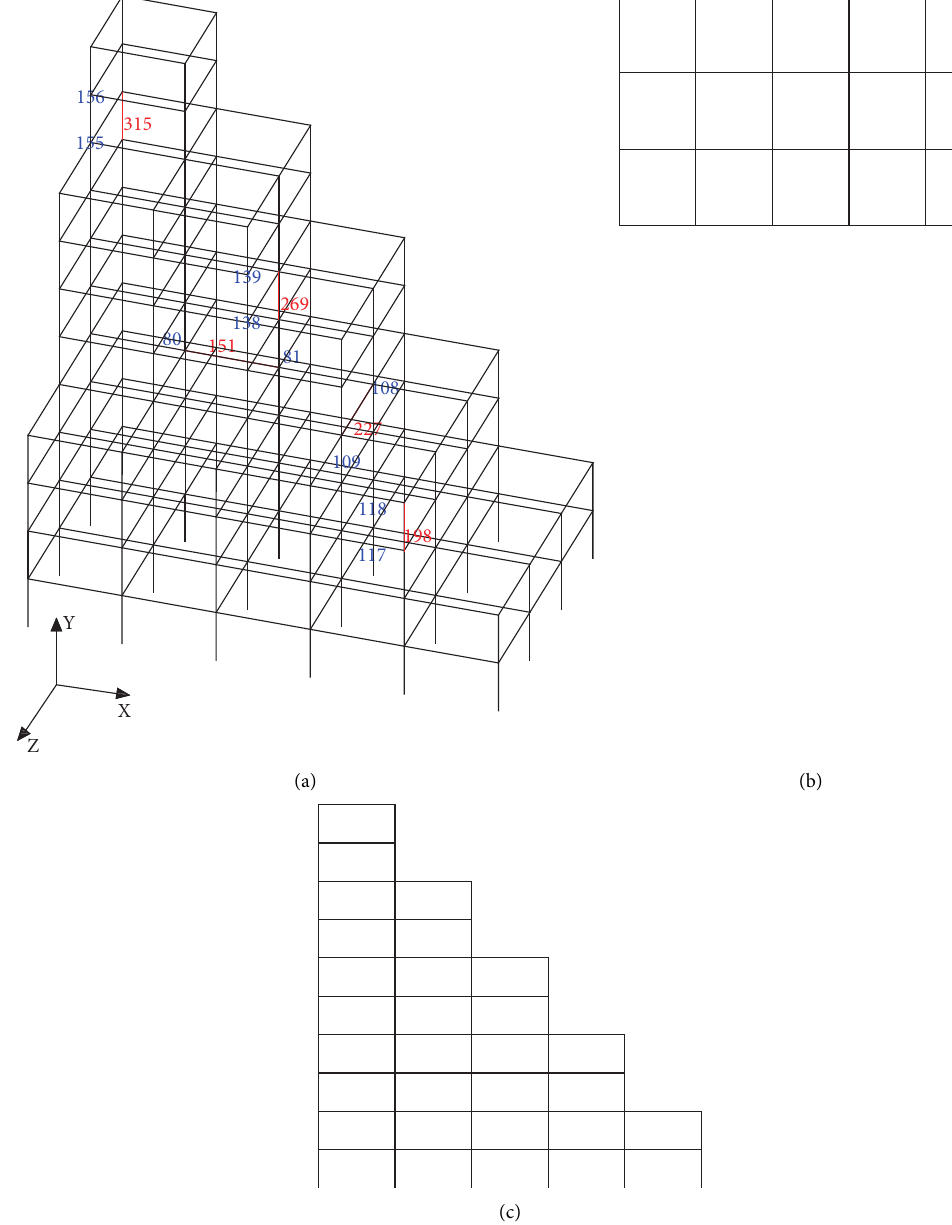
Figure 3: The general modeling scheme and induced damage members of the setback structure. (a) 3D view. (b) Plan view. (c) Elevation